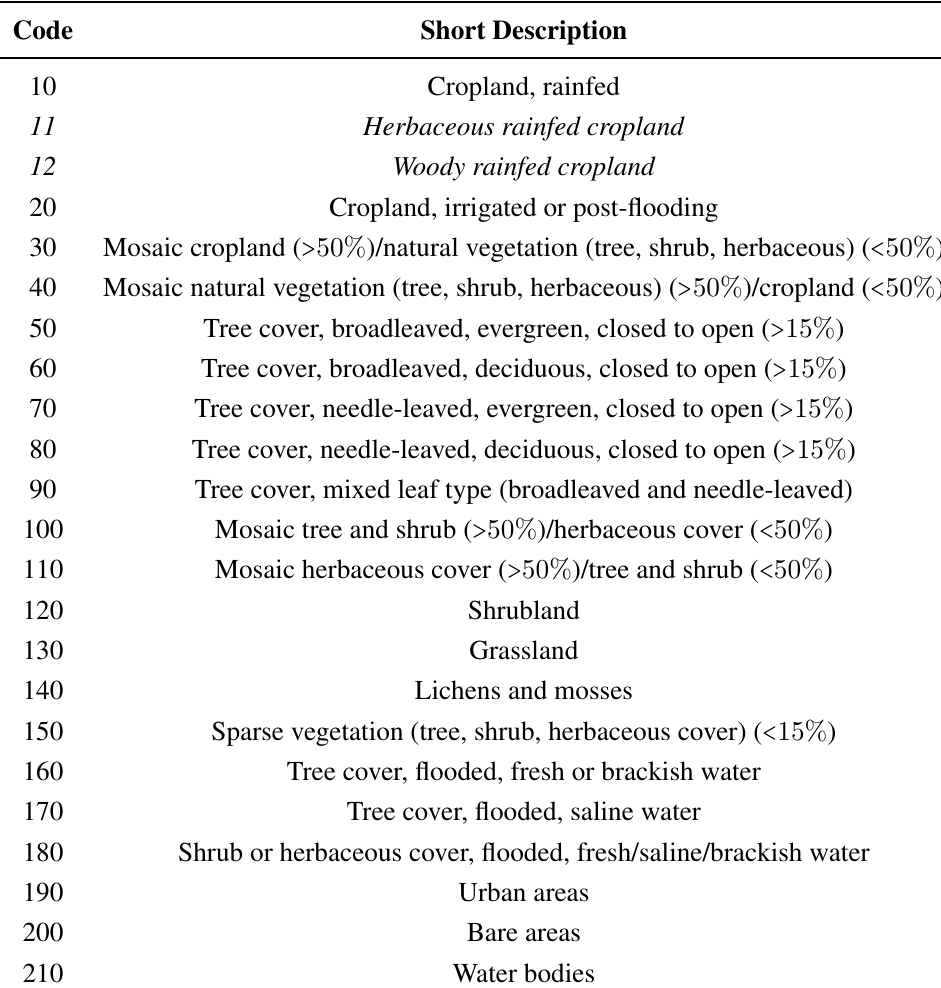
Table 1. Short description of the land cover legend used in the study. Regional classes, used only in the Eurasian region, are written in